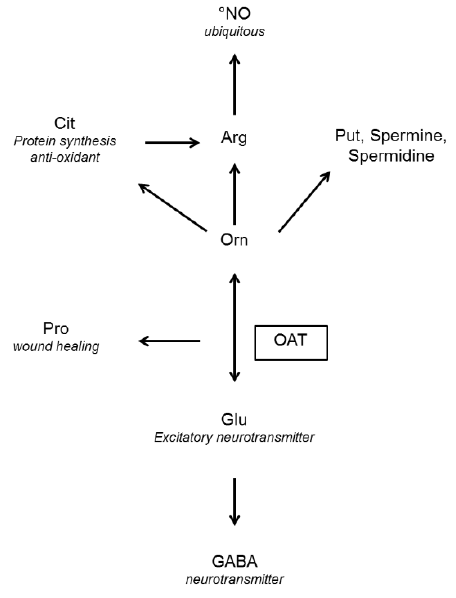
Figure 1. End products of the reaction mediated by ornithine (Orn) aminotransferase (OAT) and their functions (in italics) GABA: γ-aminobutyric acid, Glu: glutamate, Pro: proline, Arg: arginine, Cit: citrulline, Put: putrescine, NO: nitric oxide.